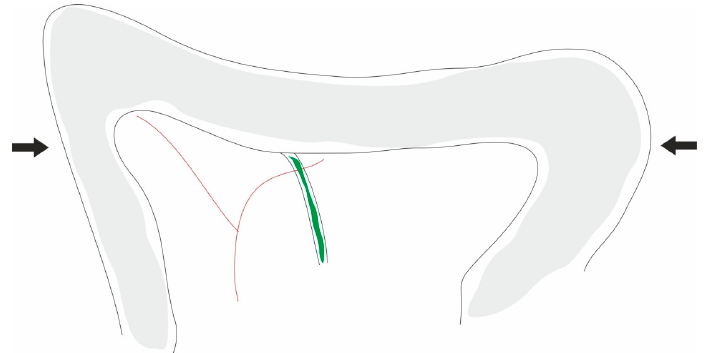
Figure 2. Closed duodenal loop acute pancreatitis model. Image: picture showing the location of the closed loop of the duodenum. According to aseptic techniques, the duodenum is exposed by a laparotomy, the common biliopancreatic duct is identified, and the duodenum is obstructed by the placement of two ligatures: one just beyond the pylorus—that is, proximally to the duct—and the second placed distally to the duct (arrows).